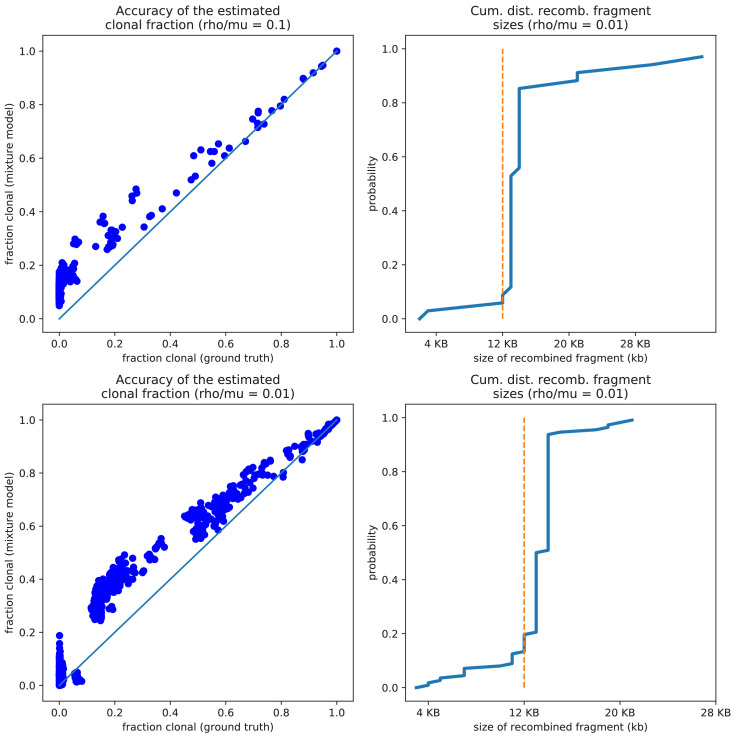
The pairwise analysis accurately estimates both the clonally inherited fractions and the sizes of the recombined segments for the simulation data.The pairwise analysis accurately estimates both the clonally inherited fractions and the sizes of the recombined segments. Left panels: Comparison of the true fraction of the genome that was clonally inherited (horizontal axis) and the estimated fraction from the pairwise analysis (vertical axis) for the simulation with ρ/μ=0.1 (top) and 0.01 (bottom). Each dot corresponds to one pair and the diagonal line shows the line y=x. Right panels: Cumulative distribution of the lengths of the recombined segments, as estimated by the pairwise analysis of the simulations with ρ/μ=0.1 (top) and 0.01 (bottom). The vertical dotted lines show the ground truth, that is all recombined segments were 12 kb long in the simulations.